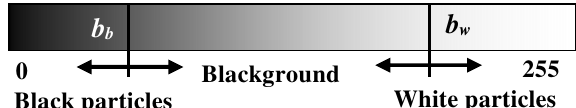
Fig. 3. Range of shade in image and boundary of white and black particles .